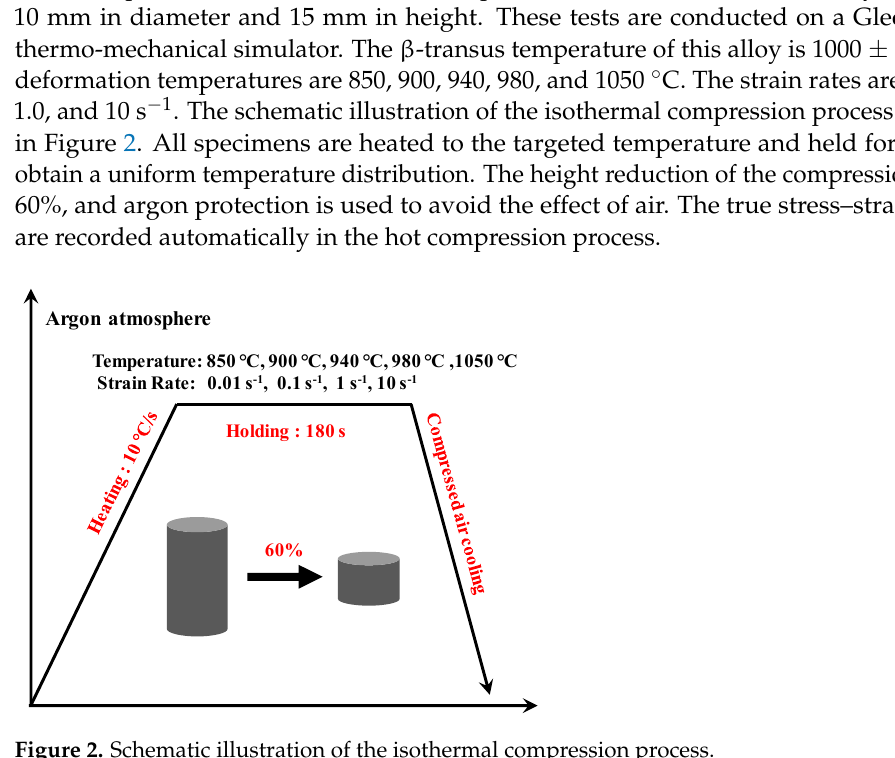
Figure 2. Schematic illustration of the isothermal compression process.